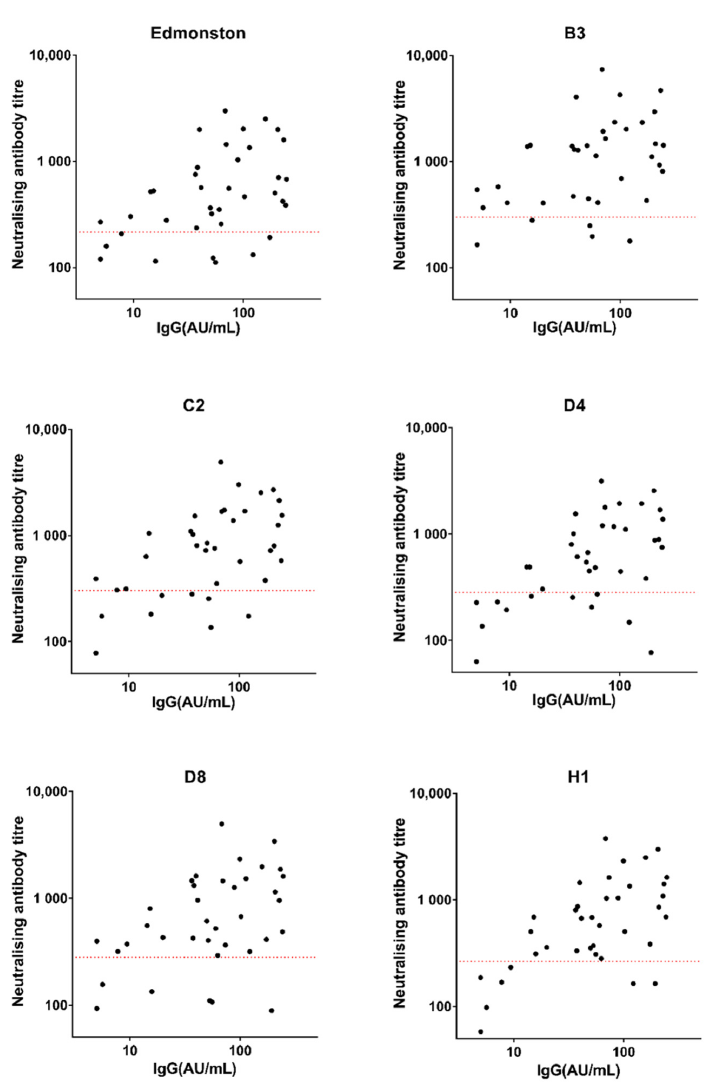
Figure 2. Measles-specific IgG levels (measured by kit from LIAISON ® ) and neutralising antibody titres in samples collected from Sheffield HCWs. The dotted red lines indicate the titre of the 3rd WHO reference serum (NIBSC 97/648) diluted to 120 mIU/mL, defined as the protective threshold. Table 2. Spearman’s rank correlation coefficient between IgG levels (measured by kit from LIAI- SON ® ) and neutralising antibody titres in Sheffield HCWs.